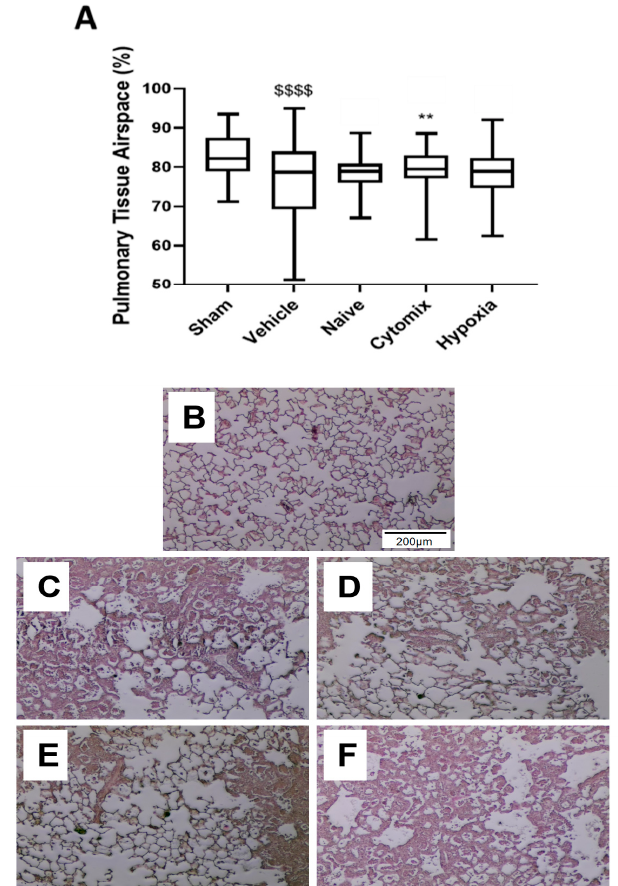
Figure 3. Sections of PFA-fixed, H&E-stained, and paraffin-embedded lung tissue were analyzed using stereology for the percentage of airspace present in the lungs ( A – F ). Representative images of the sham ( B ), vehicle ( C ), naïve ( D ), cytomix ( E ), and hypoxia ( F ) histology. Animals receiving cytomix-pretreated MSCs had a significantly higher airspace fraction compared to the vehicle control ( A ). Box plots and whiskers represent the minimum, first quartile, median, third quartile, and maximum. ** = p ≤ 0.01 with respect to the vehicle control. $$$$ = p ≤ 0.0001 with respect to the sham group. N =